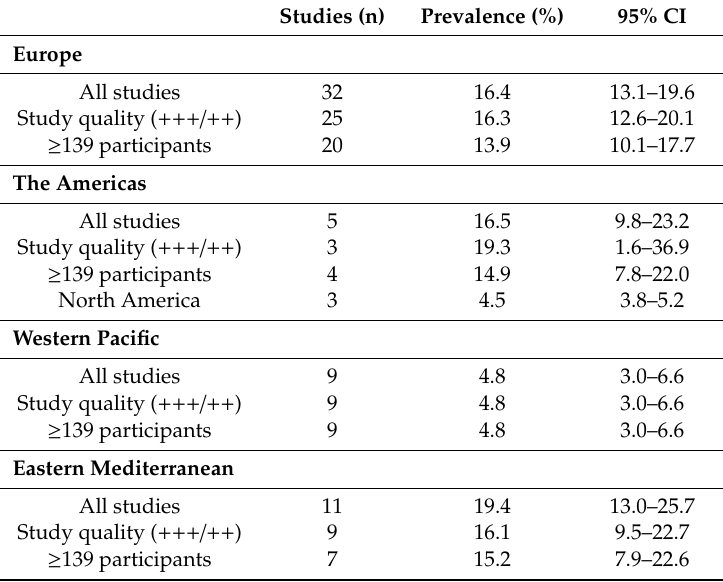
Table 2. Pooled prevalence estimations for LTBI by WHO